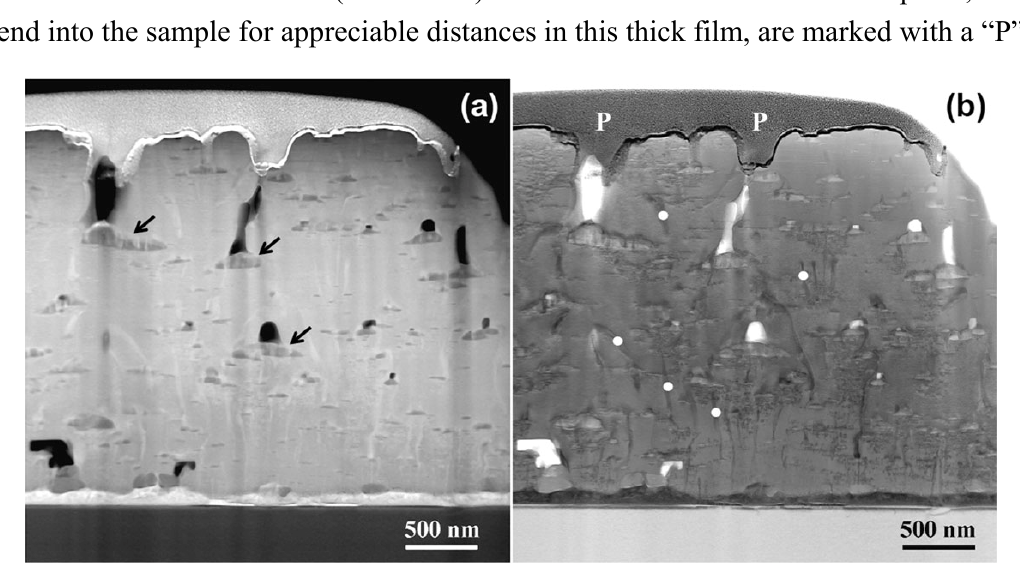
Figure 10. STEM Z-contrast image and associated EDS spectral images showing that large, striped secondary phases are actually composites of Y